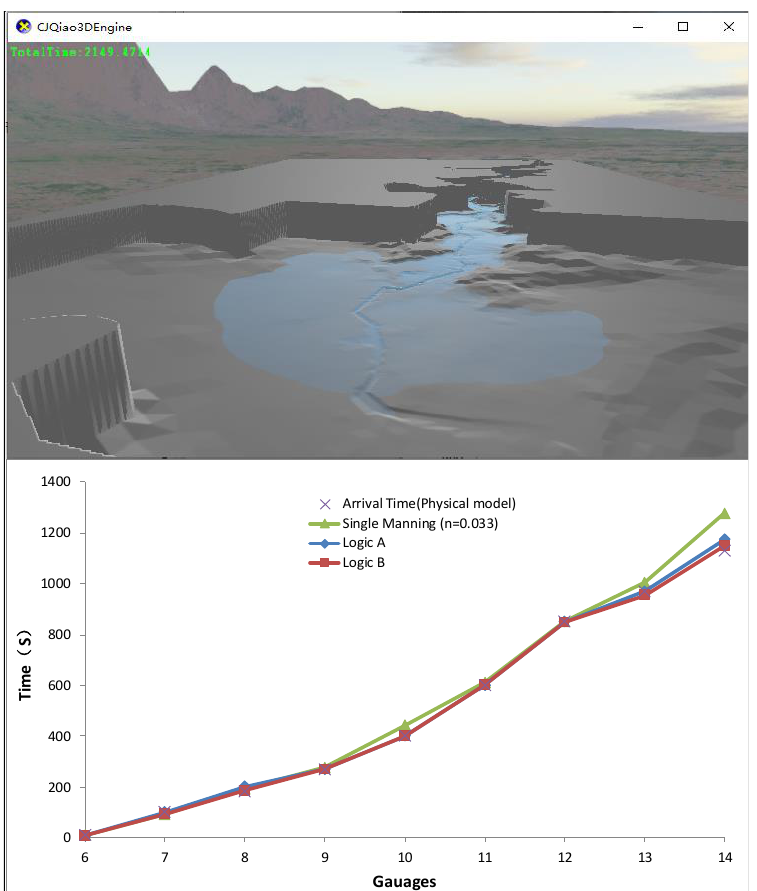
Figure 16. Arrival time of different numerical simulations on the Malpasset Dam